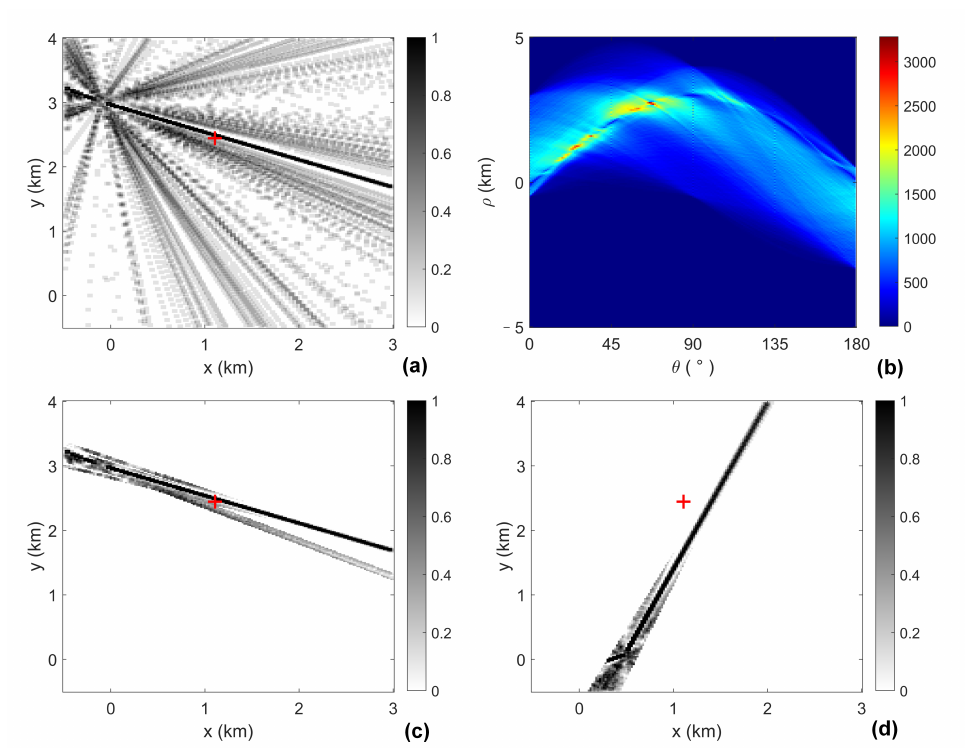
Figure 11. (Color online) ( a , b ) The wideband Peak Distribution (PD) pattern and the secondary accumulating matrix of array 1; ( c , d ) The fusion of the recovered narrowband mainlobe peaks of array 1 and 3. The red plus markers indicate the true position of the target.